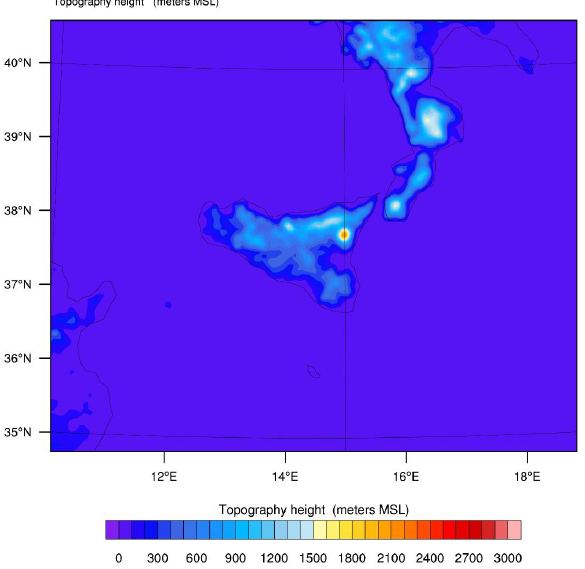
Figure 6. Topographical height (expressed in meters above sea level) of the domain under exami- nation.